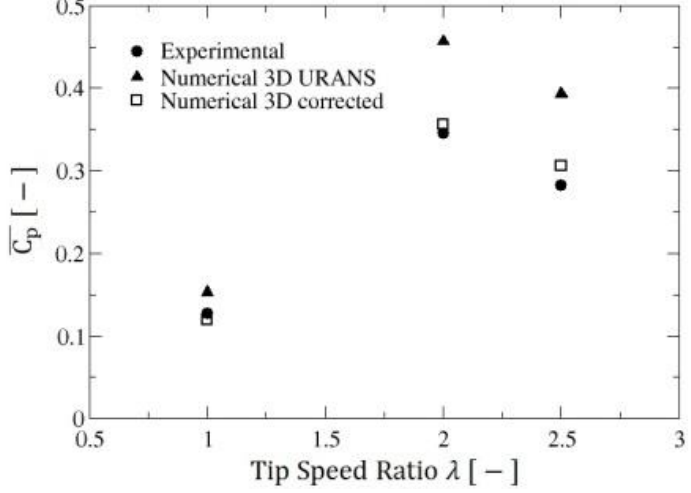
Figure 9. Average power coefficient for λ = 1, λ = 2, λ = 2.5. Numerical results vs. experiments.